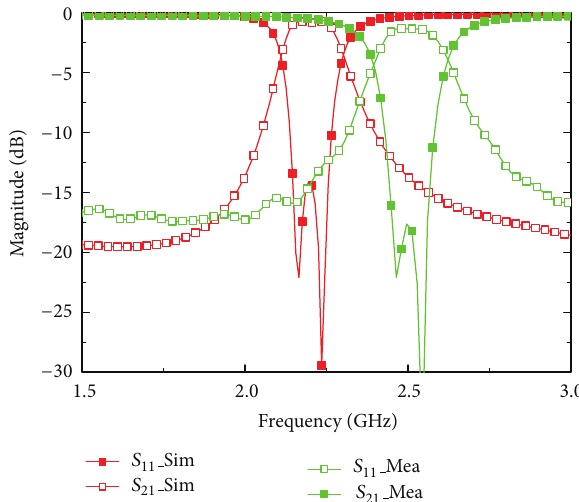
Figure 5: Simulated frequency response relative to changes in the number of the metal walls.